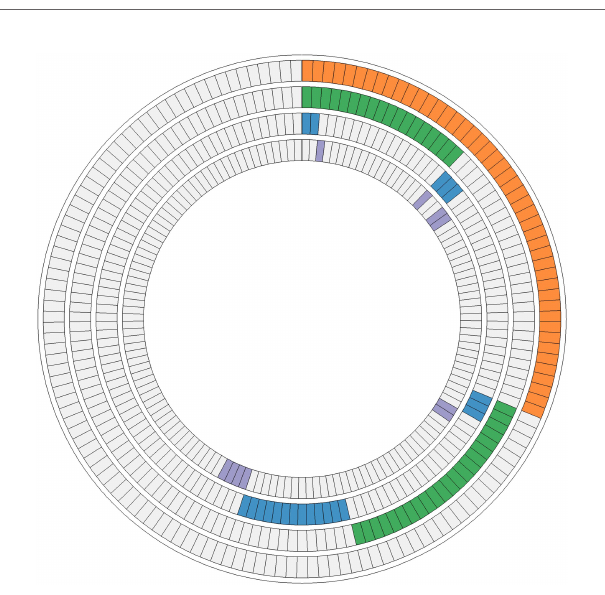
FIGURE 4 | Ten interaction networks constructed from canonical maps including the mutations found in 147 luminal breast tumors. In the concentric circle diagram, tumors are arranged as radial spokes and categorized by their mutation status in each network (concentric ring color). Orange, genome integrity, proteolysis, and apoptosis; green, MAPK signaling and PI3K signaling; blue, RTK signaling and Hippo signaling; purple, Notch signaling, Hedgehog signaling, and Wnt